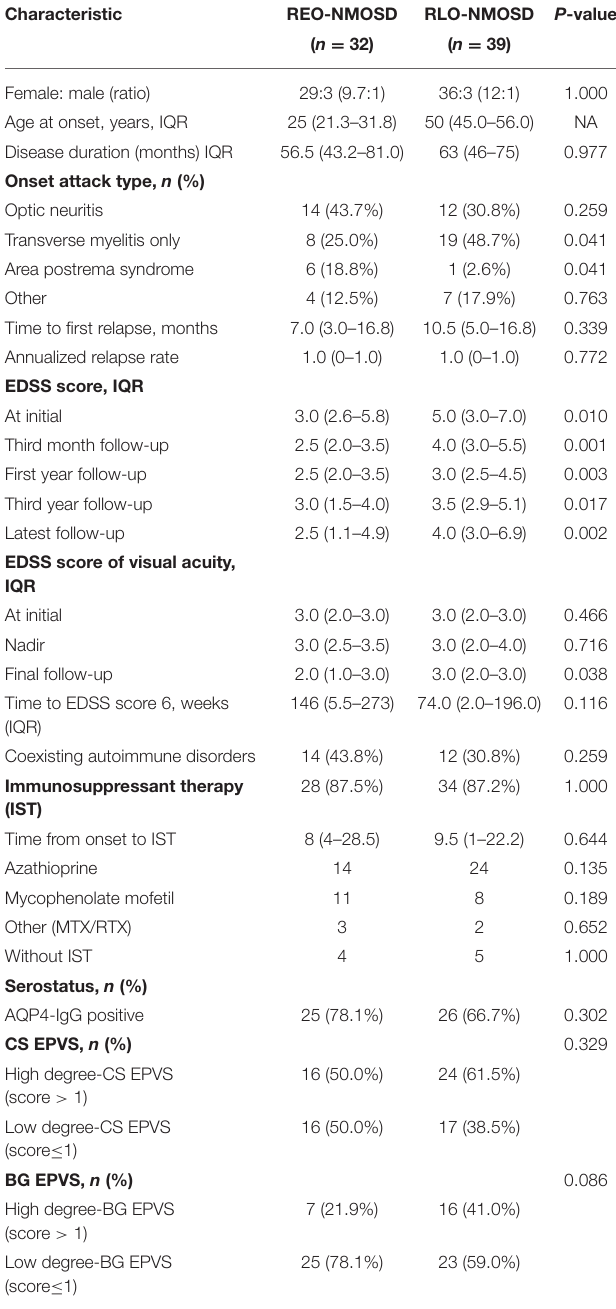
TABLE 1 | The demographic and clinical characteristics of patients with neuromyelitis optica spectrum disorder (NMOSD) according to age group (<40 or ≥ 40